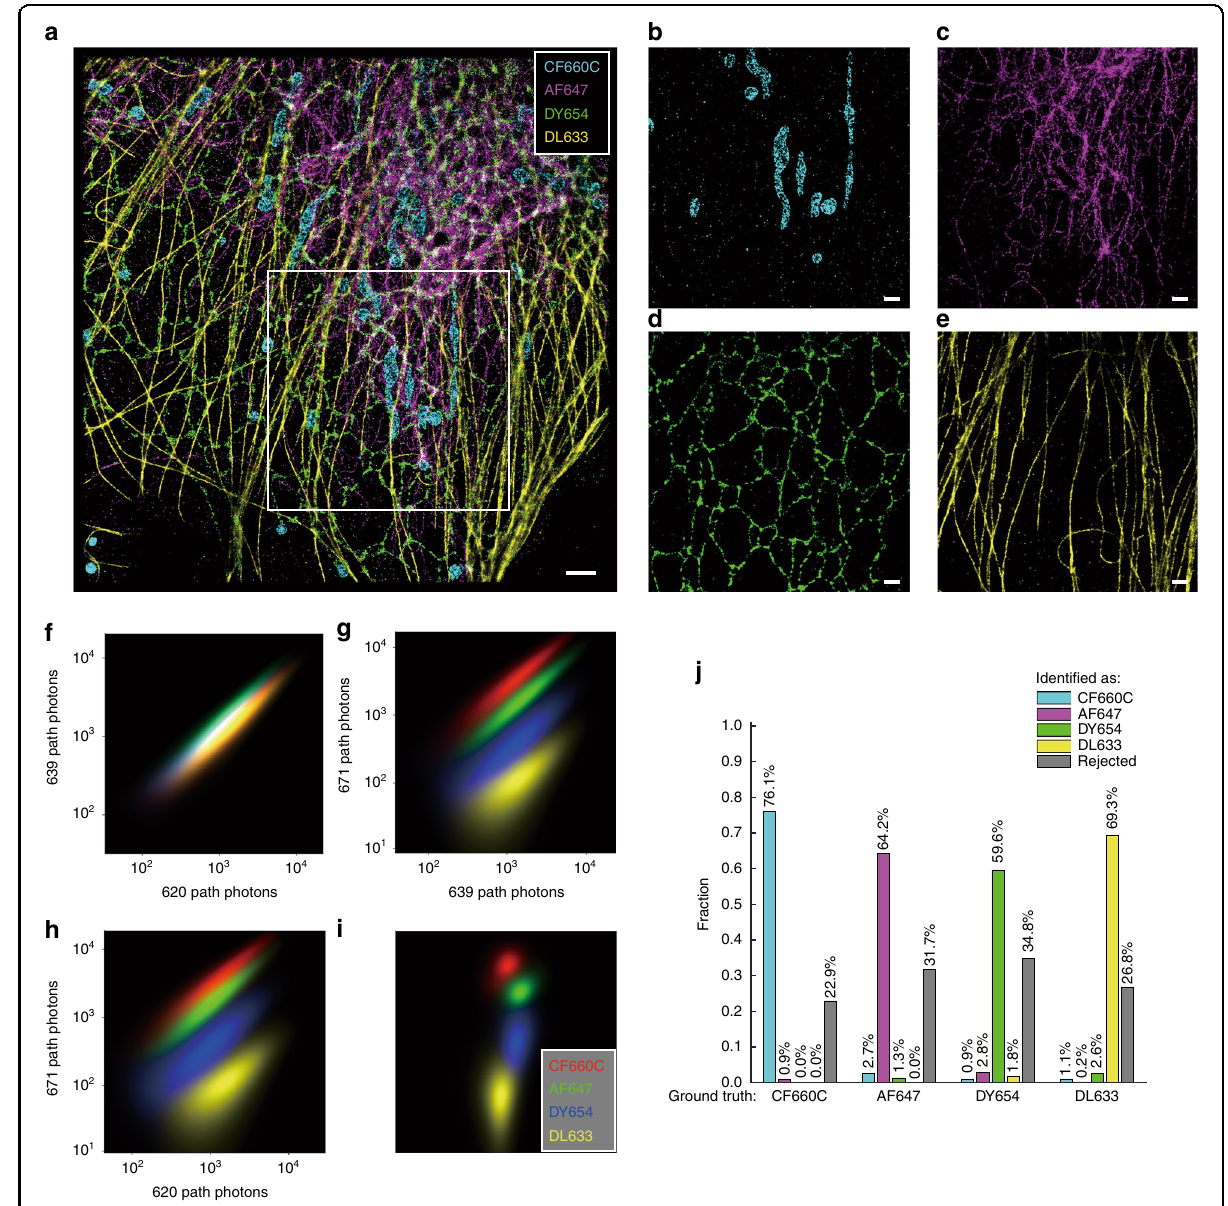
Fig. 4 Tetra-color imaging based on ExR-STORM. CF660C, Alexa Fluor 647, Dyomics 654, and DyLight 633 were selected to label the outer mitochondrial membrane (cyan), intermediate fi laments (magenta), endoplasmic reticulum (green), and microtubules (yellow), respectively, in a fi xed COS-7 cell. a Four-color superresolution reconstruction image in which each detected single molecule was classi fi ed based on the excitation spectrum of the fl uorophores. b-e Split channels of the white box region in ( a ). f – i 2D projections of the photon number distributions along the 671 path, 620 path, 639 path, and the isometric projection (which is an axonometric projection in which the three coordinate axes appear equally foreshortened and the angle between any two of them is 120°). j Cross-talk and rejected fraction for the four dyes. Scale bars: 2 μ m ( a ); 1 μ m ( b-e